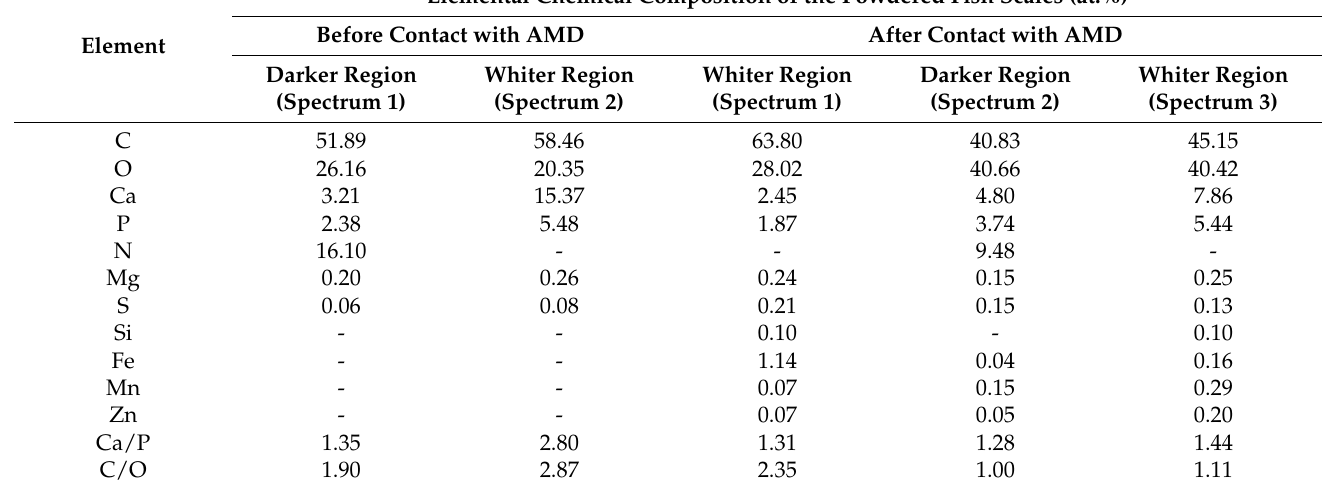
Table 3. EDX analysis of the Cyprinus carpio scales before and after 240 min of contact with the acidic mine drainage